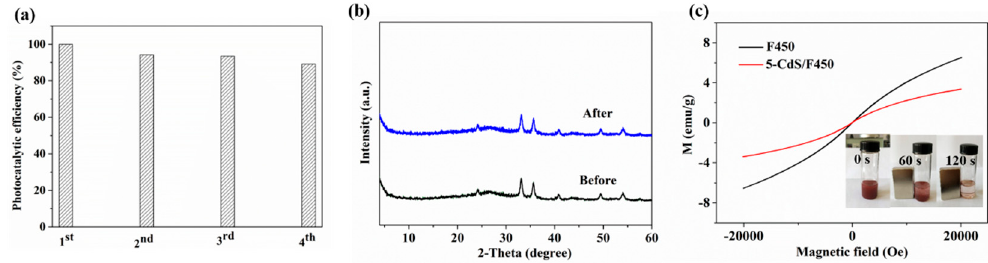
Figure 8. ( a ) Cycling test on 5-CdS / F450 for the photocatalytic degradation of bisphenol A under visible light irradiation; ( b ) XRD patterns of 5-CdS / F450 before and after the catalytic reaction; ( c ) room-temperature magnetization curves of samples, the inset is the digital photographs demonstrate the separability of 5-CdS / F450.